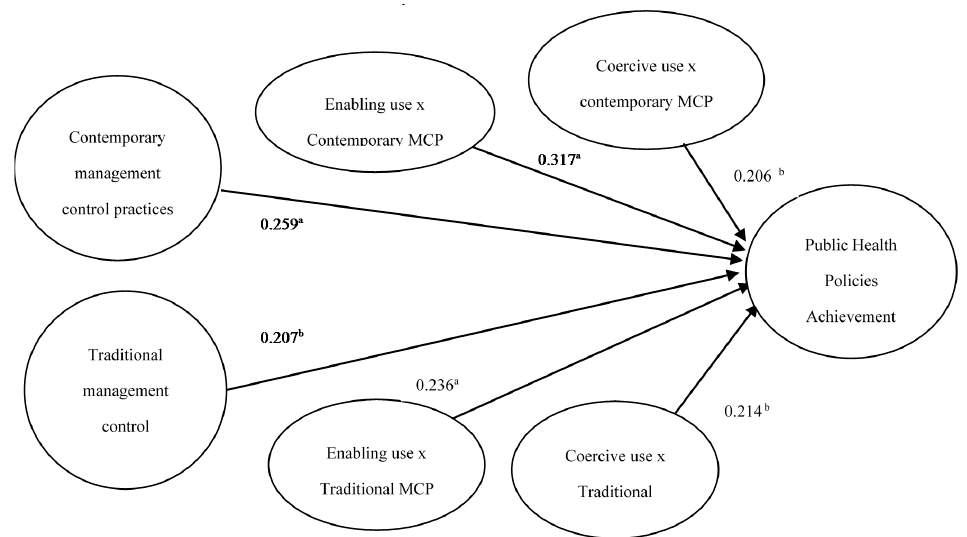
Figure 2. Results from PLS research model. a Significant at 0.01 level (two tailed); b Significant at 0.05 level (two tailed).